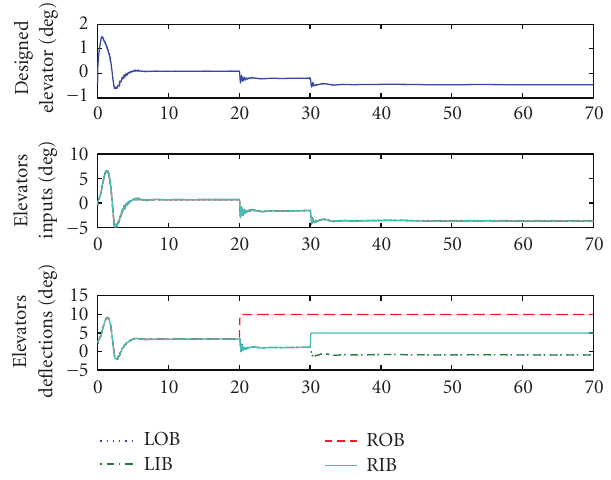
Figure 20: Time history of lumped and allocated elevators and elevator